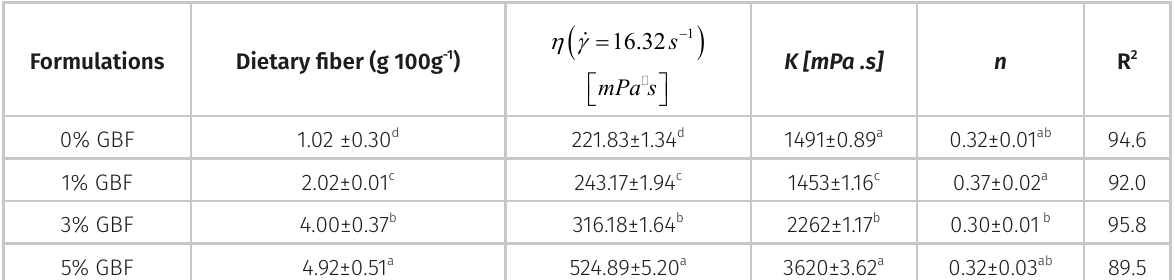
Table III. Dietary fiber content and rheological parameters of guava juice formulations containing 0, 1, 3 and 5% of guava by-product